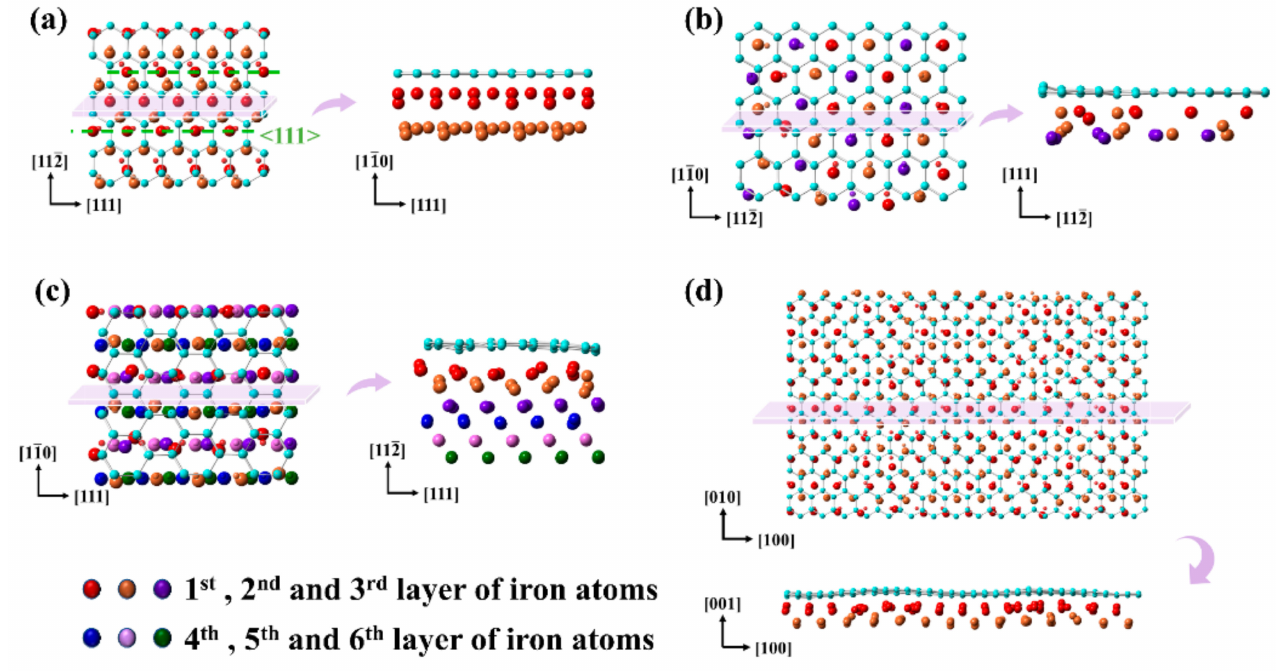
Figure 6. Atomic structures at the graphene/Fe ( a ) (110), ( b ) (111), ( c ) (112), and ( d ) (001) interfaces, corresponding to the red region in Figure 5a–d,